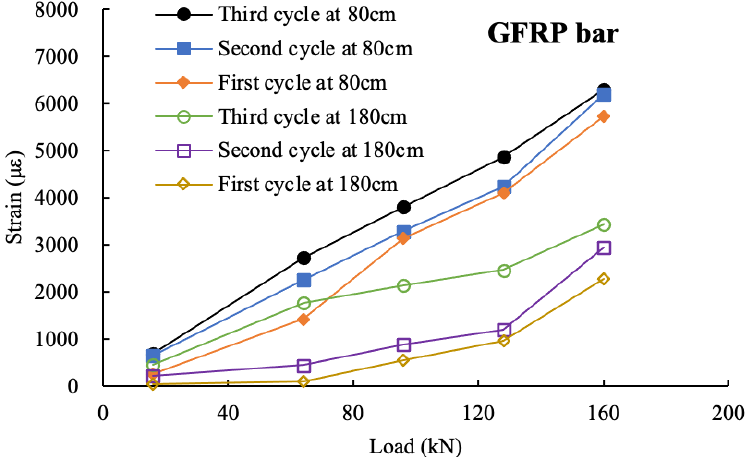
Figure 9. Strain-load relationship curve of the GFRP bar at anchorage depths of 80 cm and 180 cm. In conclusion, both steel and GFRP bar bodies in soft rock are affected by cyclic load, which can aggravate the bond damage of the bar interface. The steel and GFRP bars in soft rock are both affected by the previous maximum load, which is the main influencing factor of the bond damage of the anchorage bar, compared with the number of times of cyclic